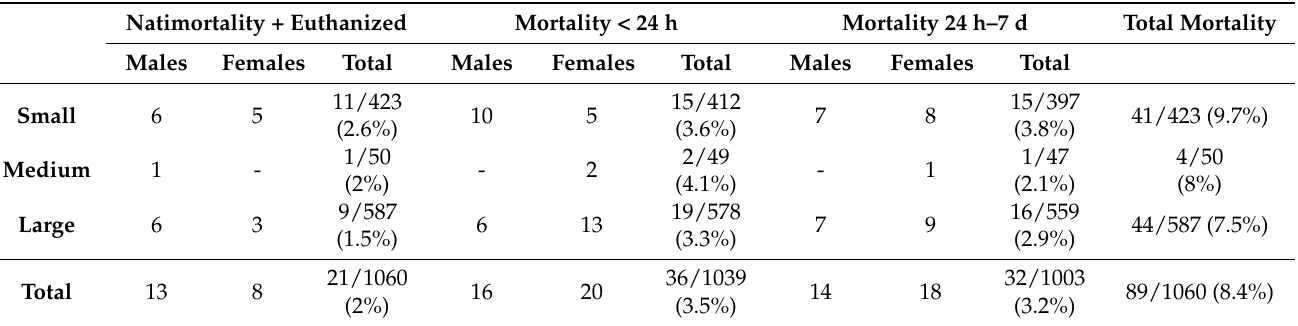
Table 4. Data about the natimortality plus euthanized puppies, neonatal mortality at < 24 h after birth and at 24 h–7 days (d) of age, and total mortality in puppies grouped according to